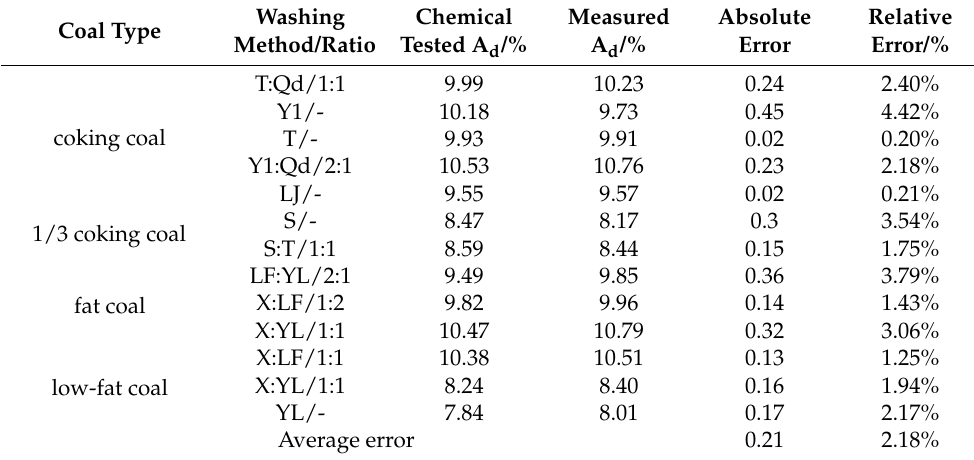
Table 12. Average ash content per day in April for coal in the western part of the Linhuan Coal Preparation